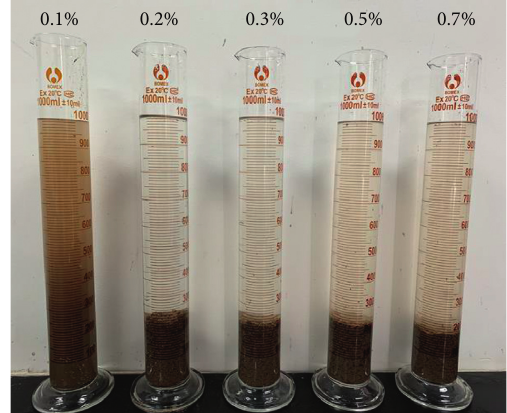
Figure 6: Photo of slurry settlement 1h after the addition of CPAM12.